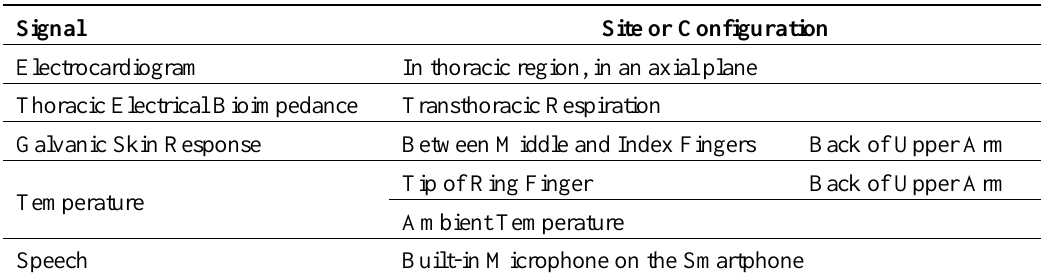
Table 1. Signals recorded on the